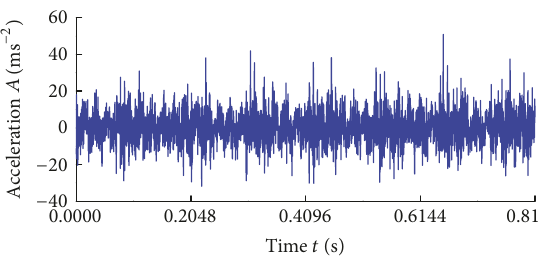
Figure 12: Vibration signals of a bearing roller fault.